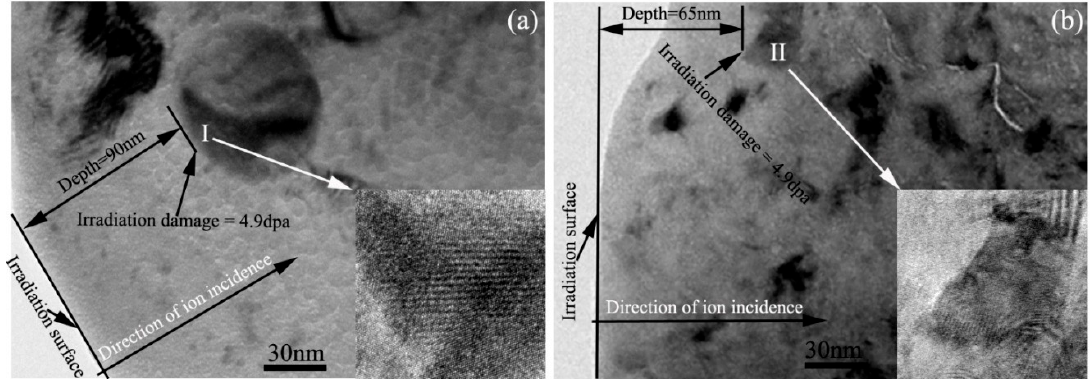
Figure 5. TEM bright field images showing the microstructure of the Zr alloys irradiated with 1.43 × 10 15 Kr + /cm 2 fluence at 360 ◦ C. ( a ) Zr alloy #1; ( b ) Zr alloy 10 15 Kr + /cm 2 fluence at 360 °C. ( a ) Zr alloy #1; ( b ) Zr alloy #2.